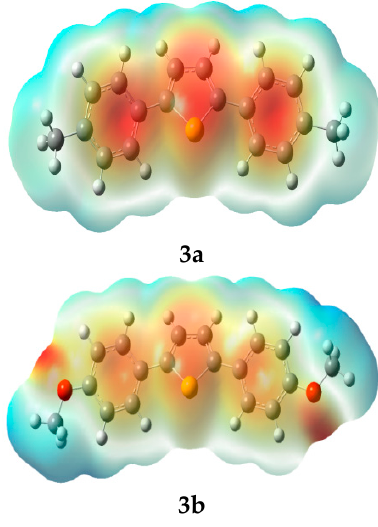
Figure 7. Cont. Figure 7.